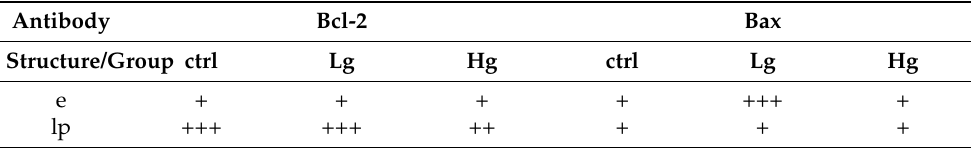
Table 2. Staining intensity of Bcl-2 and Bax in the control human colon and CRC (low-grade and high-grade).